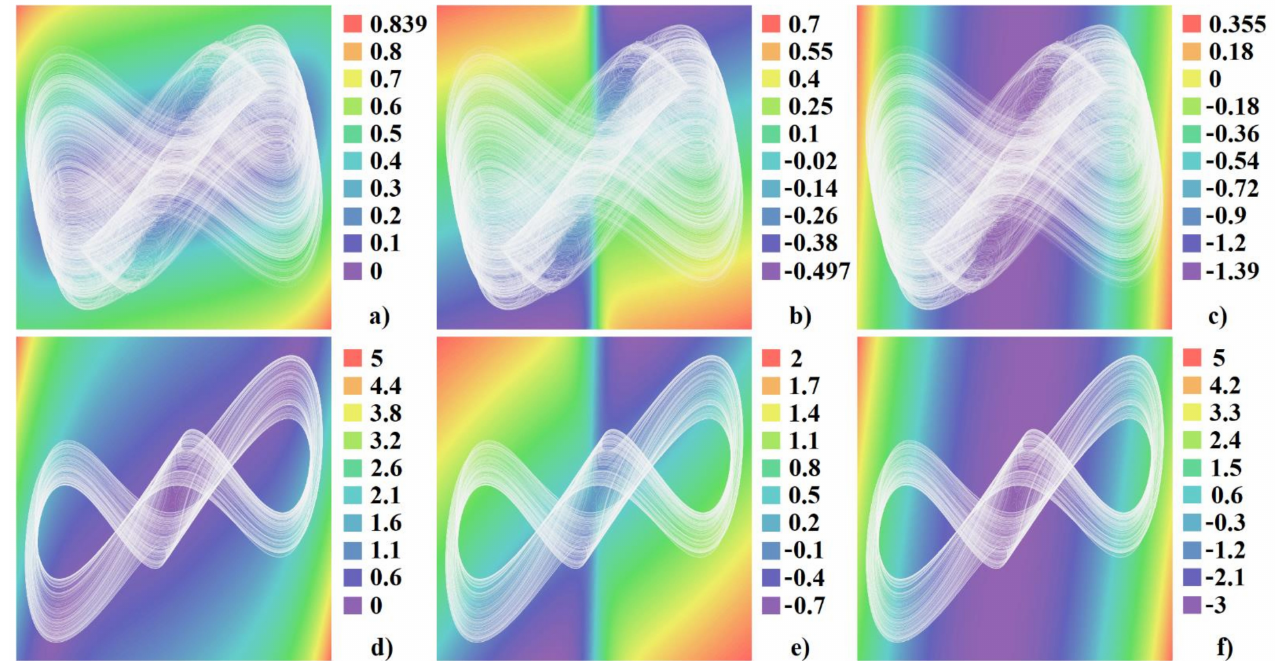
Figure 9. For both Darlington-type composites, calculation of the kinetic energy, the static energy loss and divergency of vector field visualized in v 1 - v 2 plane (rainbow scaling legend is included). Fourth order system (11) with value set (22) we obtained: ( a ) dynamic energy loss for v 3 = 0 V and i L = 0 A, ( b ) static energy loss for v 3 = 0 V and i L = 0 A, ( c ) divergency for v 3 = 0 V and i L = 0 A. For third order system (16) with values (24) we get: ( d ) dynamic energy for v 3 = 0 V, ( e ) static energy loss for v 3 = 0 V, ( f ) vector field divergency for v 3 = 0 V. Energies are related to 1 s time instance.